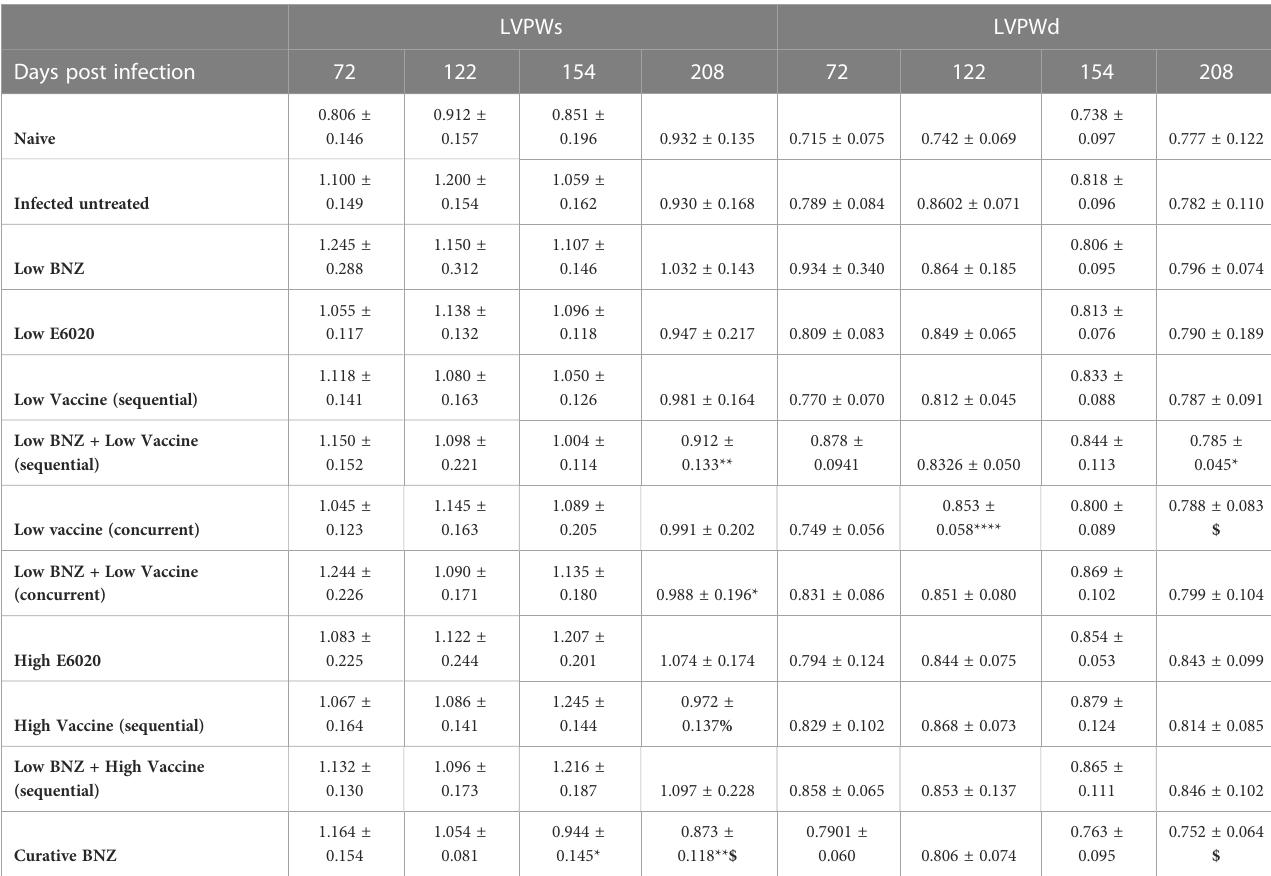
Leftventricularposteriorwallthickness.Themean±SDofleftventricularwallthicknesswasmeasuredfromM-modeechocardiographyimagesduring systole(LVPWs)anddiastole(LVPWd).Whencomparing to 72 DPI, * ≤ 0.05, ** ≤ 0.01, **** ≤ 0.0001. When comparing to 122 DPI, $ ≤ 0.05,When comparing to 154 DPI % ≤